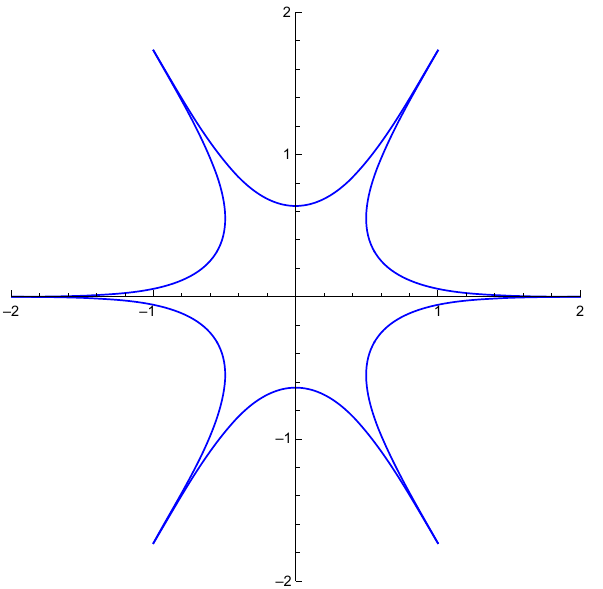
Fig. 1 Spiky D-string which has 6 spikes in AdS space